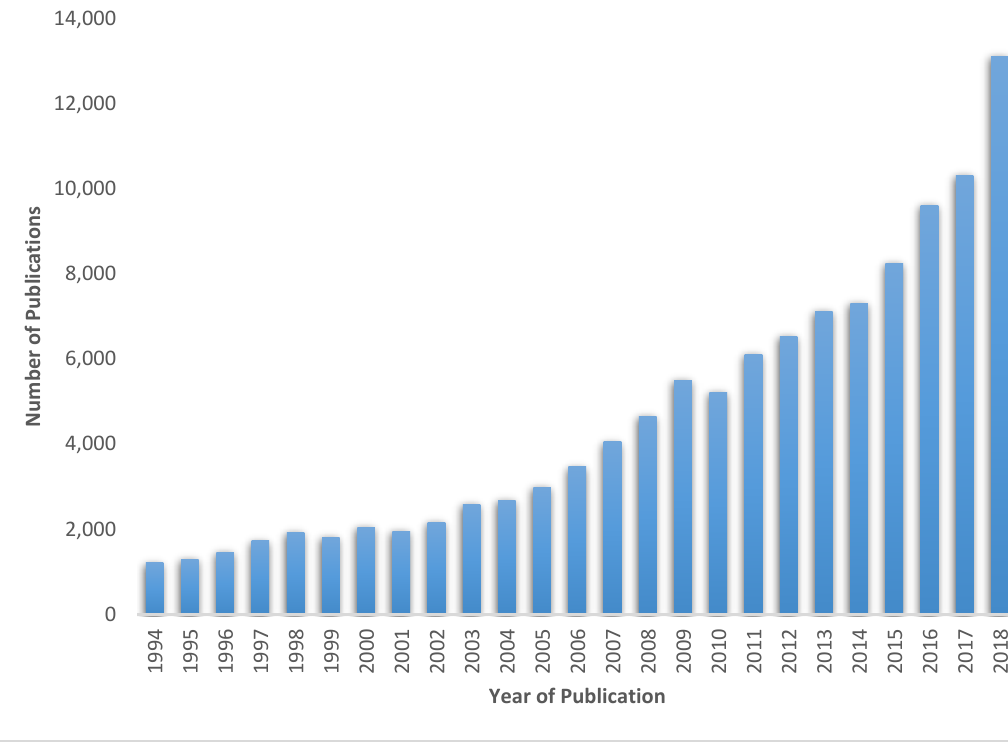
Figure 1. Ever-increasing attention of researchers towards environmental sustainability and destination of waste demonstrated by the number related publications per year (Web of